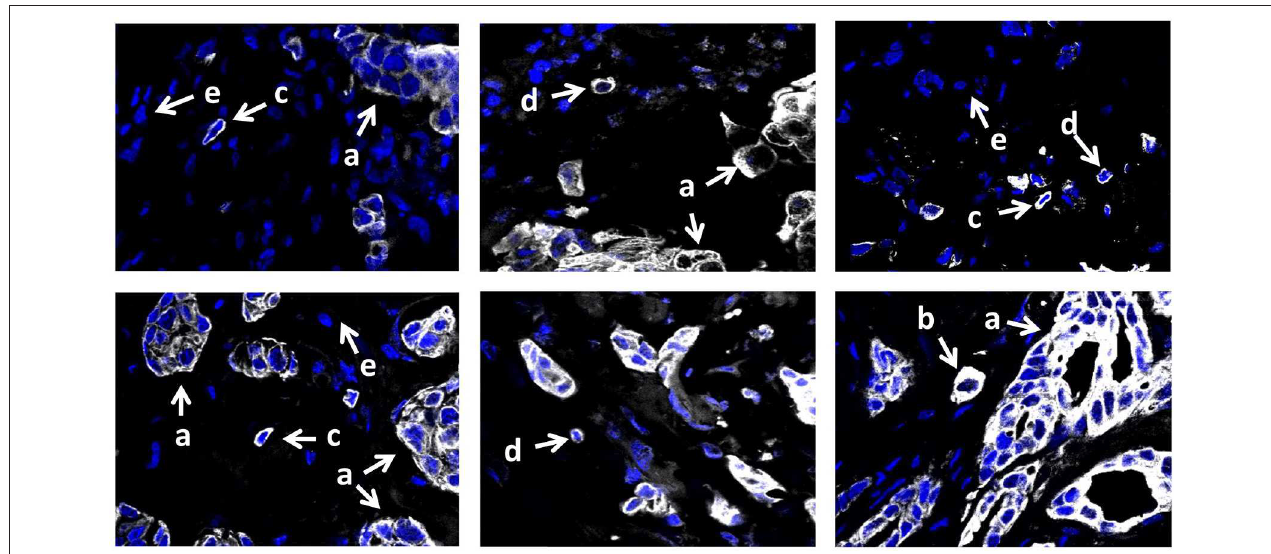
FIGURE 4 | CK7 expression in invasive breast carcinoma of no special type. Multicellular structures are formed by tumor cells with epithelial morphology (marked by the letter “a”). Few CK7-positive STCs have epithelial morphology and do not differ from tumor cells of multicellular structures (marked by the letter “b”). Numerous CK7-positive mSTCs with fibroblast- (marked by the letter “c”) or lymphocyte-like (marked by the letter “d”) morphology are similar to CK7-negative stromal cells (marked by the letter “e”). 400 ×